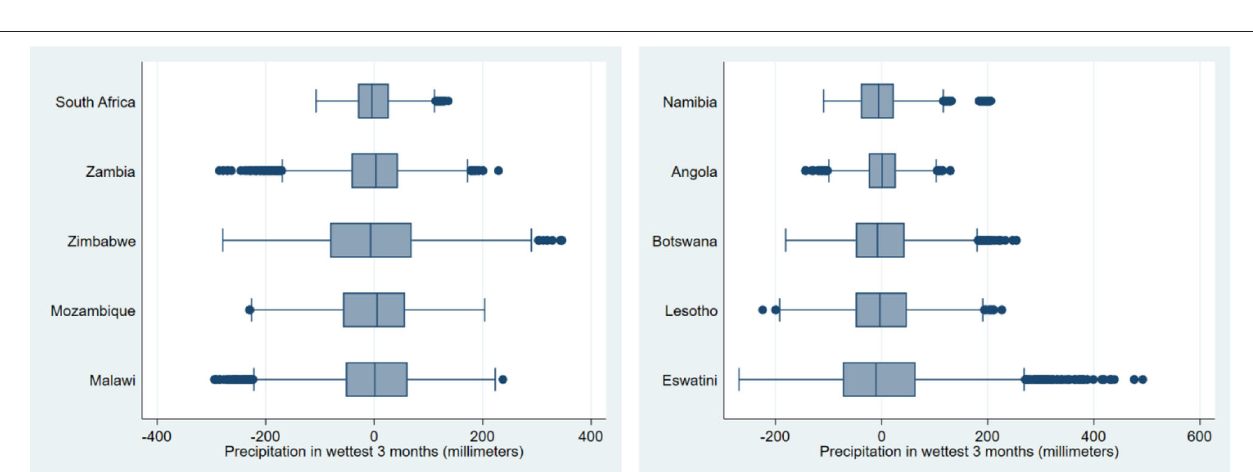
FIGURE 7 | Variation in historical precipitation of the wettest 3 months by country based on detrended monthly data, 1948–2016. Source: Authors’ calculations based on Princeton Global Forcings, version 3 [2018, based on Sheffield et al. (2006)]. For box and whisker plots, the box is bounded by the 25th and 75th percentiles, with the mid-line inside the box showing the median. The length from the 25th to the 75th percentile is called the inter-quartile range (IQR). The endpoint of the whiskers is the point that just lies within a distance of 1.5 times the IQR from the ends of the boxes. Any point beyond the whiskers is plotted